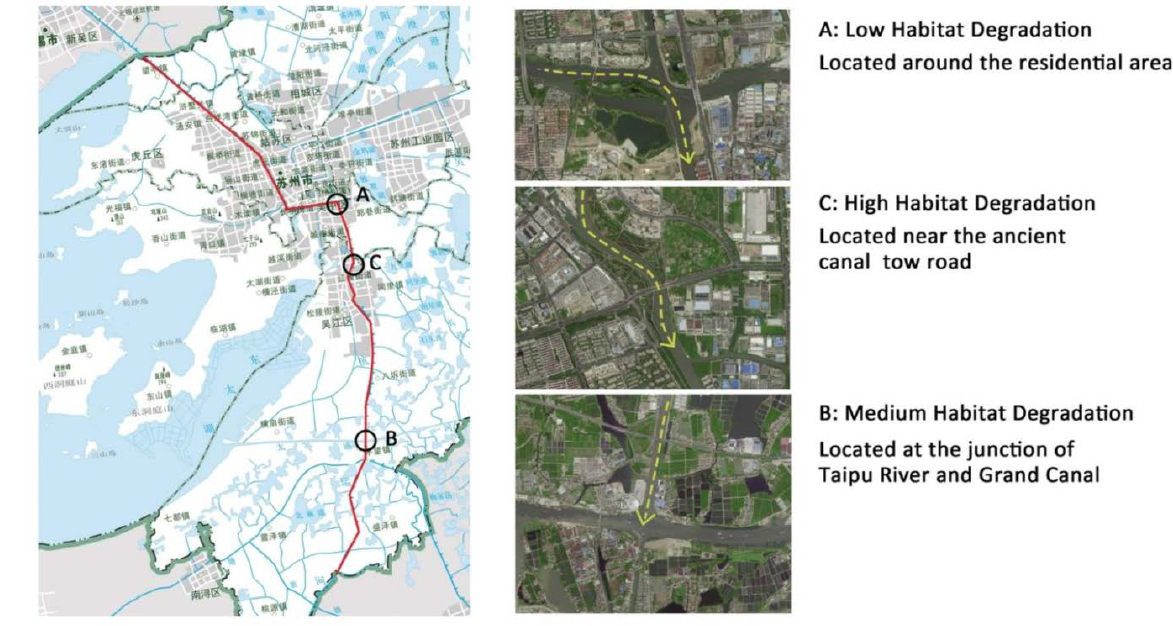
Figure 10. Three types of habitat degradation area within the Suzhou section of the Grand